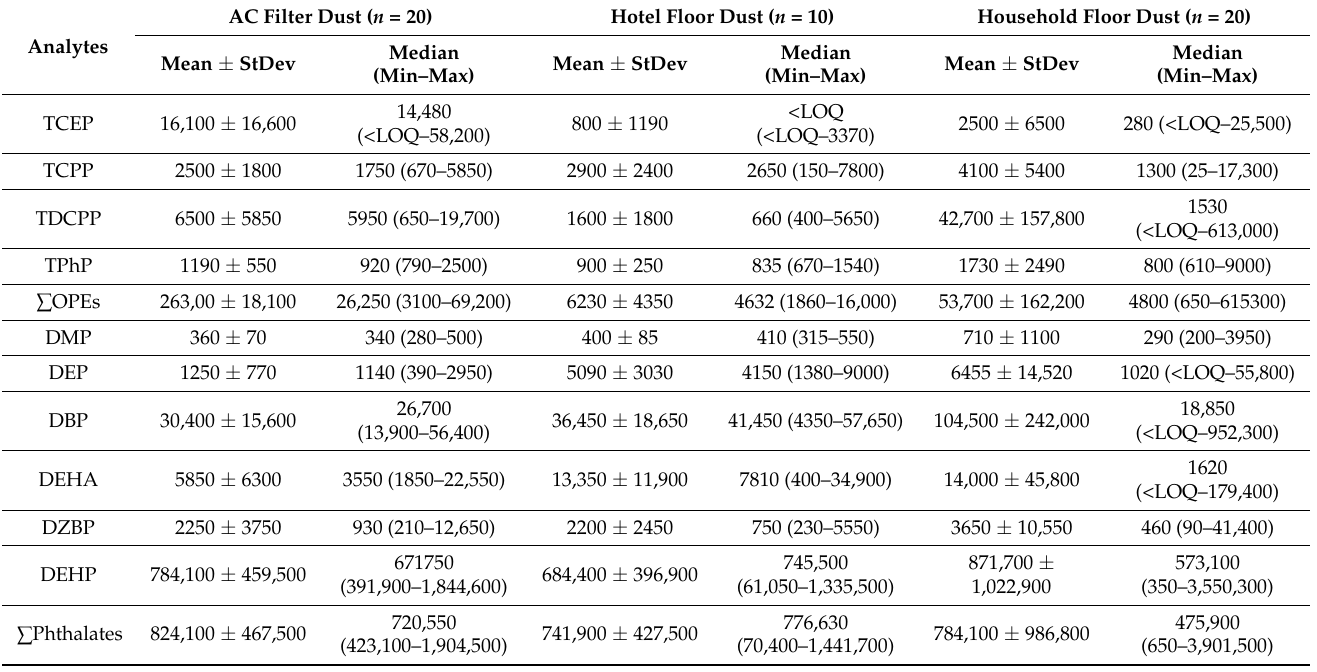
Figure 1. Contribution (%) of analyzed chemicals in PM10 of sampled indoor microenvironments of Saudi Arabia. Table 3. Concentrations (ng g − 1 ) of analyzed OPEs and phthalates in dust collected from different indoor microenvironments of Saudi